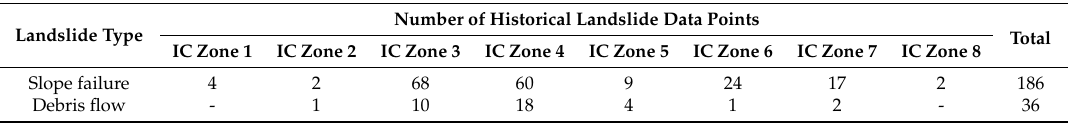
Table 3. Reclassification of 1st and 2nd class historical landslide data recorded from 2009 to 2016, according to the infiltration characteristic (IC) zone and landslide